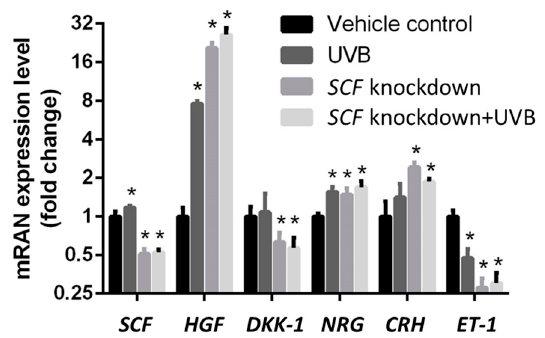
Figure 2. The influences on paracrine factors secreted by fibroblasts were compared between the vehicle control, UVB only, SCF knockdown, and SCF knockdown with UVB exposure groups. The data are presented as means ± SD; n = 3, * p < 0.05.